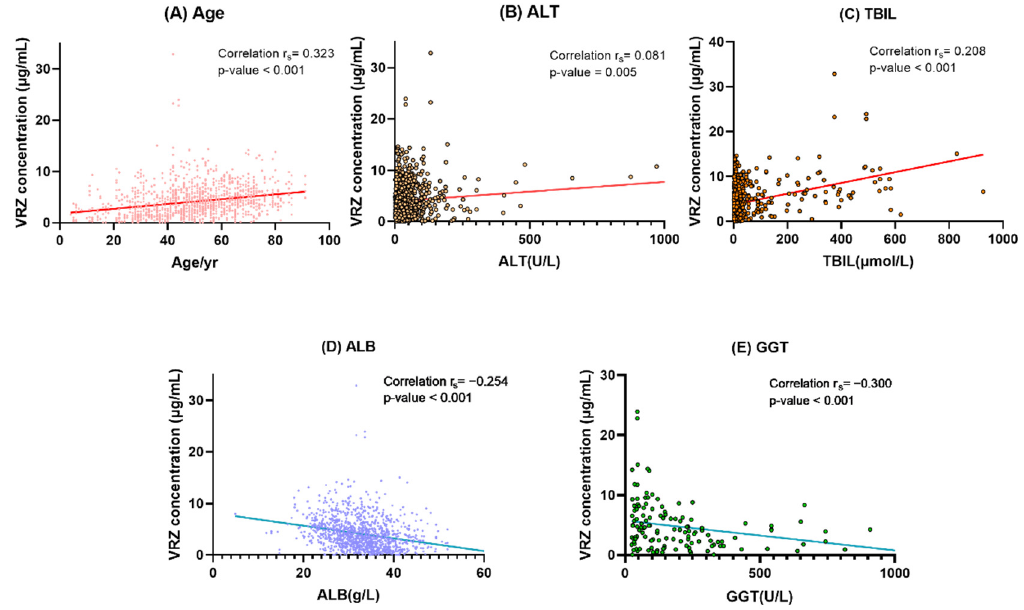
Figure 4. Correlation analysis between VRZ concentration and its determinants. ( A ) Age. ( B ) ALT alanine aminotransferase. ( C ) TBIL total bilirubin. ( D ) ALB albumin. ( E ) GGT gamma-glutamyl transferase. In ( B , D , E ), a point is omitted outside the coordinate axis. If patient age increased by 1 year, the concentration of VRZ increased by 0.049 μ g/mL.